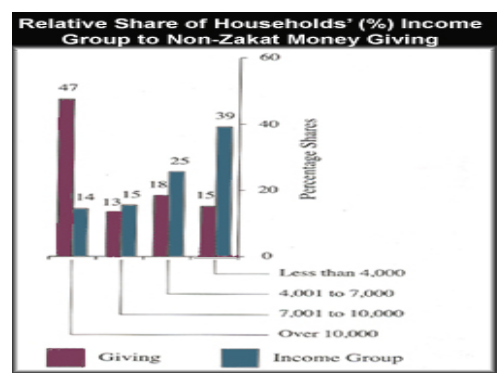
Figure 1.3: Source: Pakistan Center for Philanthropy,